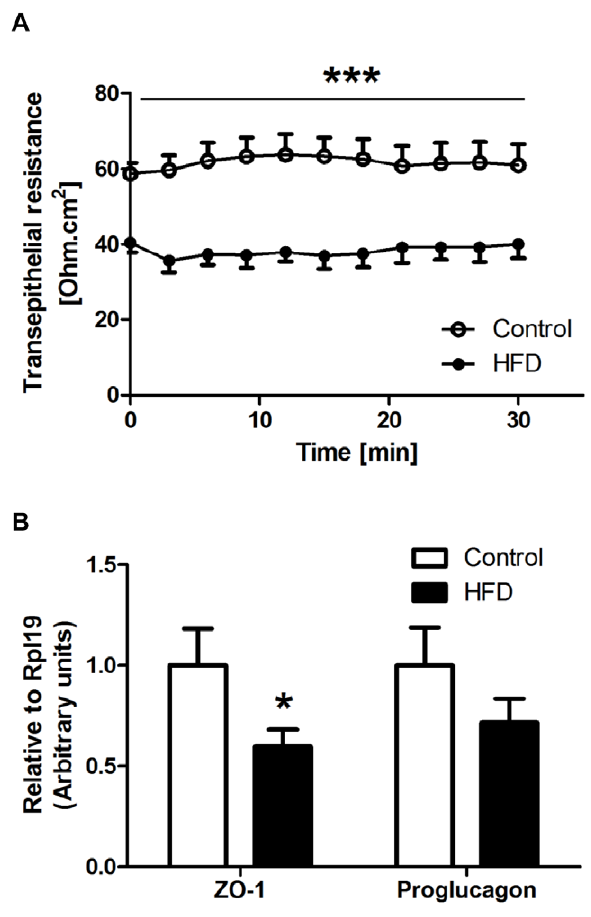
Figure 2. Effect of high saturated fat diet (HFD) on barrier function of proximal colon. A: Transepithelial resistance of mouse proximal colon was determined in the Ussing chamber by measuring the change in potential difference in response to 3 m A current generated across the tissue segment. B: mRNA levels of zona occludens (ZO)-1 and proglucagon were measured using RT-qPCR. Gene expression was normalized to RPL-19. Open circles/bars=control; Closed circles/bars=HFD (n=9–16 per group). Data are shown as mean 6 SEM. *** P , 0.001 and * P , 0.05 compared to control. doi:10.1371/journal.pone.0034233.g002 ( P = 0.025) and 28% ( P = 0.104) respectively in HFD mice (Figure 2B), whereas the mRNA levels of occludin were not different between the diet groups (data not shown). The colon tissue of the HFD treatment group had increased mRNA expression of TNF- a by 6.6-fold ( P = 0.037) but that of IL-6 was unchanged (Figure 3).